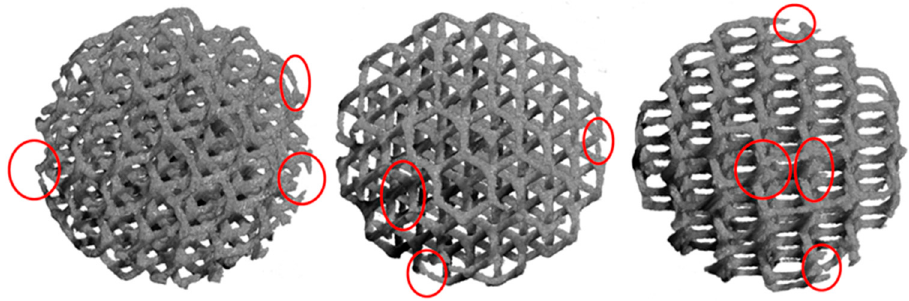
Figure 11. Models rebuilt by XmCT of the D15-0.6 beads. Broken rods, rods with uneven sections, and discontinuities at the nodes are visible.